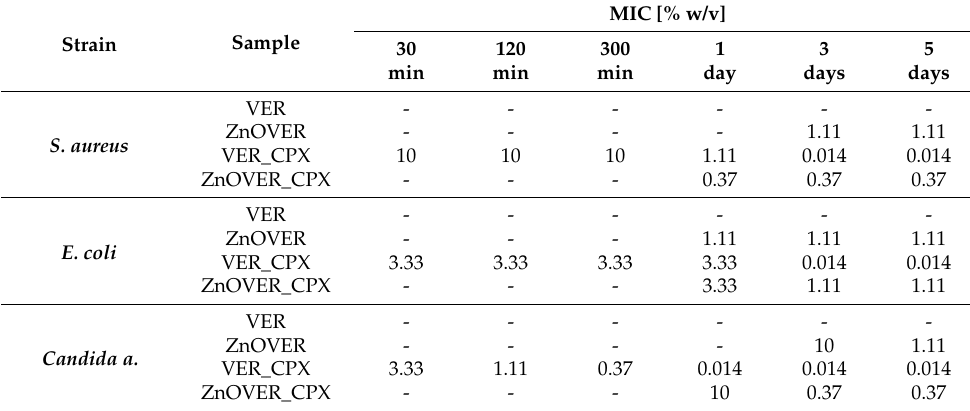
Table 5. MIC values (%) (w/v) of clay nanofillers.